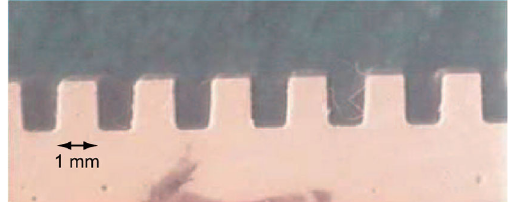
FIG. 13. Replica of the grooves for the first grooved coupler shown in Fig. 12, which is made of silicone.